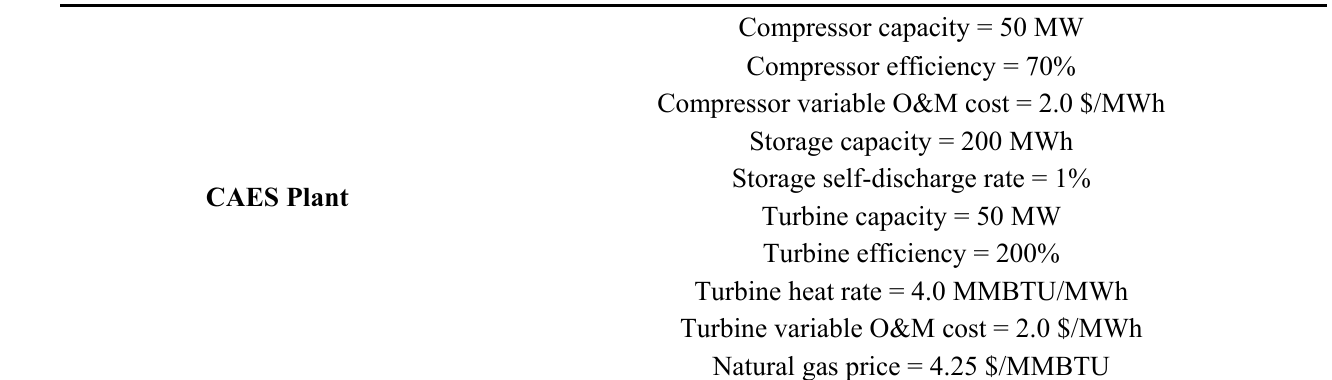
Table 3. Input data for